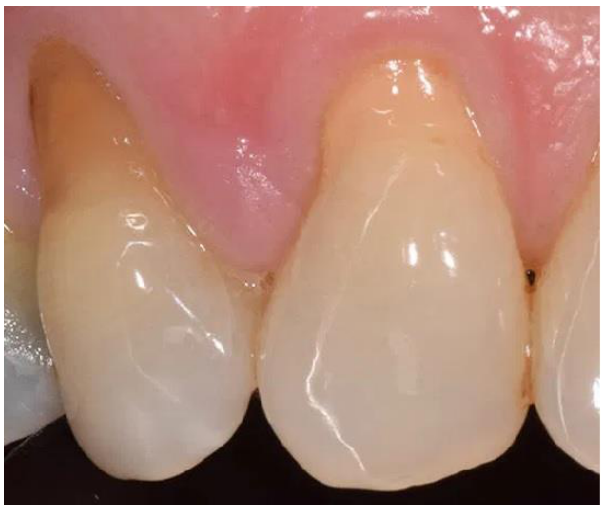
Figure 1. A non-carious cervical lesion (NCCL).